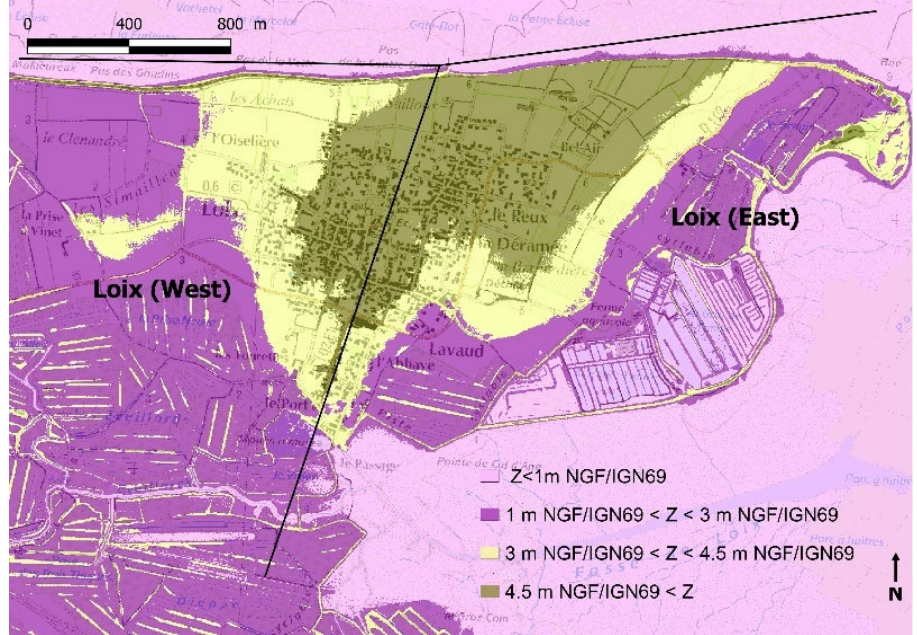
Figure 4. Synthetic topographic map. Altitudes are given using the NGF/IGN69 (French reference system).